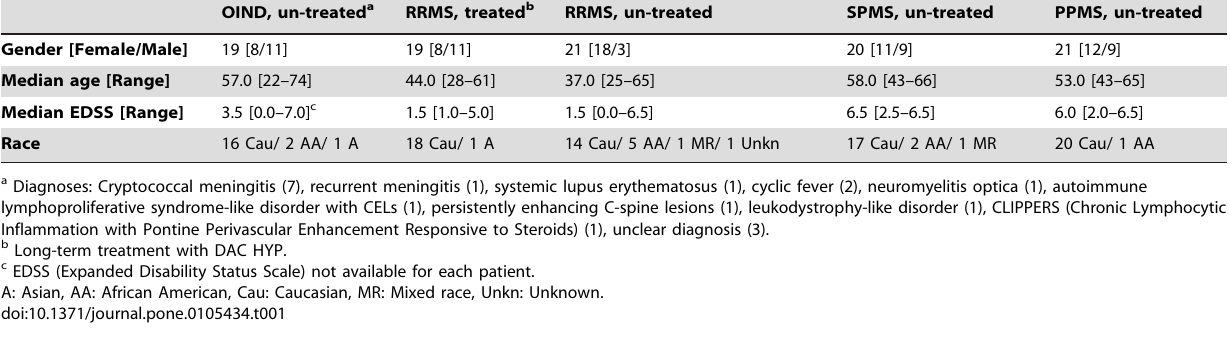
Controls, n=19 Relapsing-Remitting MS (RR), n=40